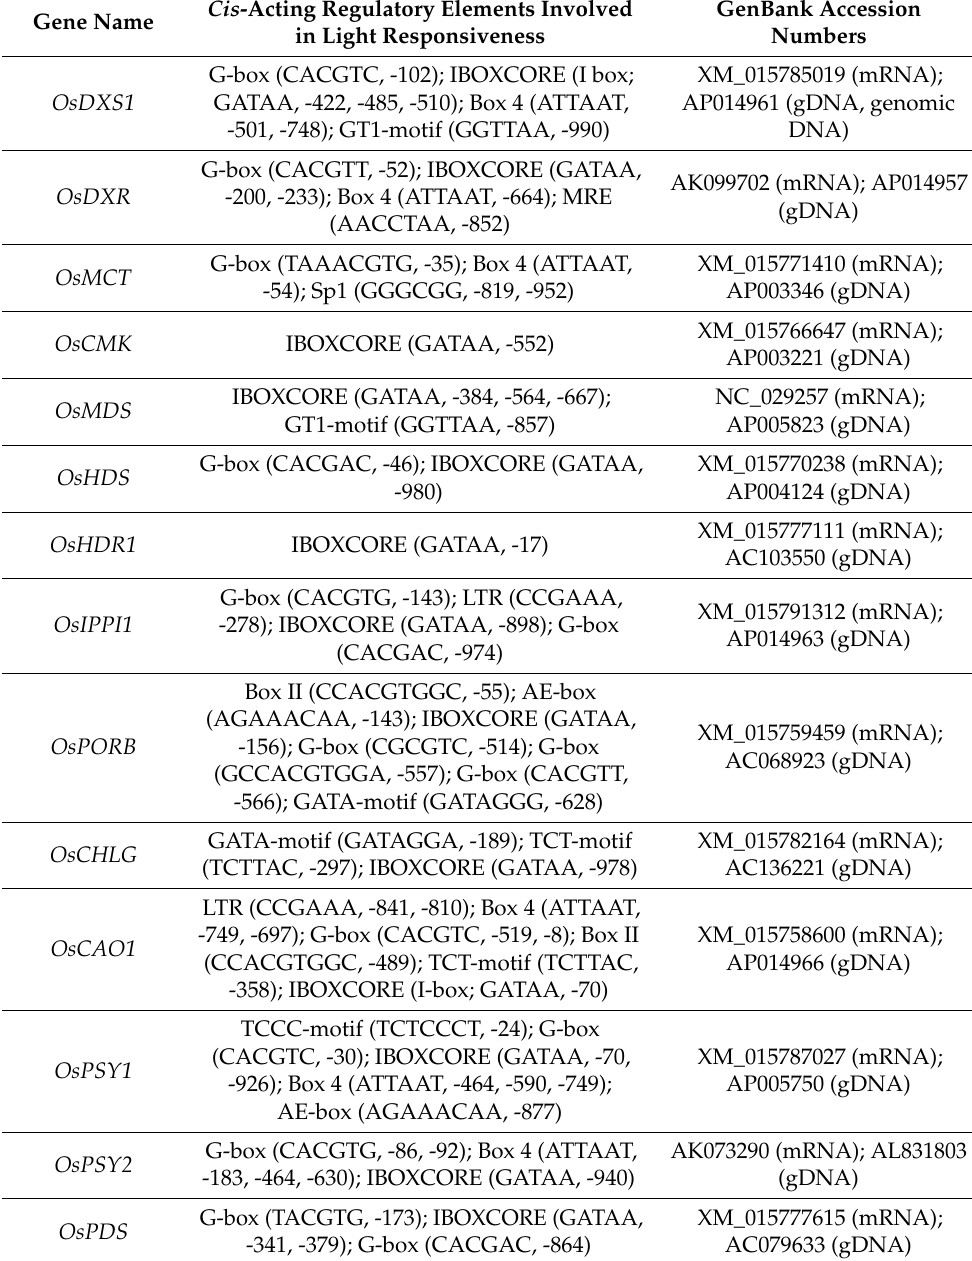
Table 1. In-silico analysis of light-responsive cis -acting regulatory elements of upregulated genes during de-etiolation of etiolated rice leaves. The positions of the cis -acting regulatory elements are relative to those of cDNA (+1 is the first nucleotide of